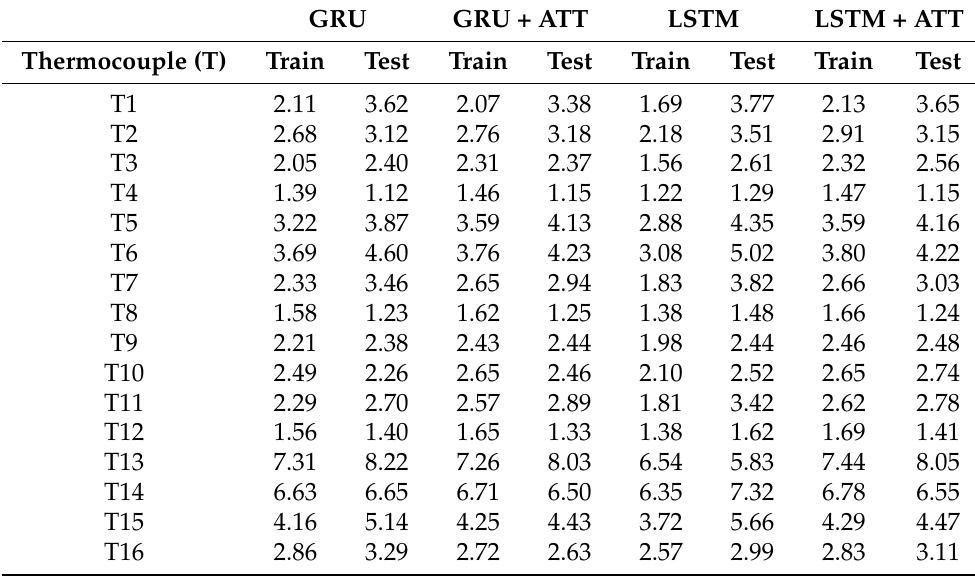
Table 2. RMSE results in the 16 thermocouples for the train and test sets versus the different deep learning models for a 6 h